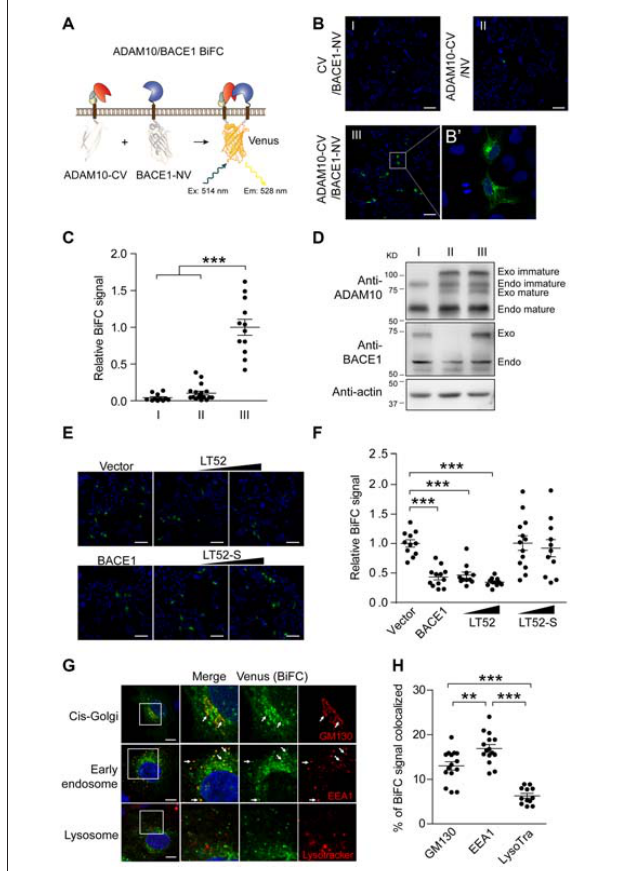
FIGURE 1 | Bimolecular fluorescence complementation (BiFC) reveals α -/ β -secretase complex. (A) Schematic for ADAM10-CV and BACE1-NV constructs. The C-fragment and N-fragment of Venus was fused to the C-terminal of ADAM10 or BACE1 respectively. CV, C-fragment of Venus; NV, N-fragment of Venus. (B) BiFC signal between ADAM10 and BACE1. HEK 293 cells were transfected with CV and BACE1-NV (I) or ADAM10-CV and NV (II) , or ADAM10-CV and BACE1-NV (III) , and fixed 16 h later for BiFC detection. The BiFC signals were examined by confocal imaging under 20 × objective, scale bar: 100 µ m or (B’) under 63 × objective. (C) Quantification of fluorescence intensity of ADAM10/BACE1 BiFC signals in (B) . Images under 20 × objective were evaluated, N = 11–18 per condition. A one-way analysis of variance (ANOVA) with Bonferroni’s multiple comparisons was used. ∗∗∗ p < 0.001. (D) Western blots show the expression of ADAM10-CV and BACE1-NV in (B) . Specific antibodies for ADAM10 or BACE1 were used to detect the endogenous and Venus fragment tagged ADAM10 or BACE1. Immunoblots show the near endogenous expression level of ADAM10-CV and BACE1-NV. (E) ADAM10/BACE1 BiFC signal is attenuated by LT52. HEK 293 cells were transfected with ADAM10-CV, BACE1-NV and designated plasmids, and fixed 16 h later. The expression of BACE1 or LT52 attenuates ADAM10/BACE1 BiFC signal, while LT52-S shows little effect. Scale bar: 100 µ m. (F) Quantification of ADAM10/BACE1 BiFC signals in (E) . N = 11–13 per condition. A one-way ANOVA with Bonferroni’s multiple comparisons was used. ∗∗∗ p < 0.001. (G) Subcellular location of ADAM10/BACE1 BiFC signal. HEK 293 cells were transfected with ADAM10-CV and BACE1-NV for 16 h, and incubated with LysoTracker, or fixed and subjected to immunofluorescence staining for GM130 or EEA1. Scale bar: 10 µ m. The arrows point to the co-localized regions. (H) Quantification of localization of ADAM10/BACE1 BiFC in cis-Golgi, early endosome and lysosome. N = 12–15 per condition. A one-way ANOVA with Bonferroni’s multiple comparisons was used. ∗∗ p < 0.01, ∗∗∗ p <